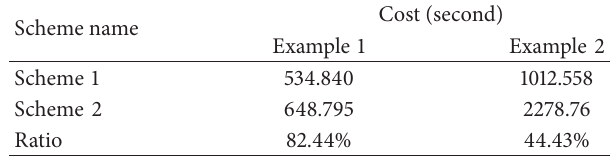
Table 3: The cost comparisons of two Web services